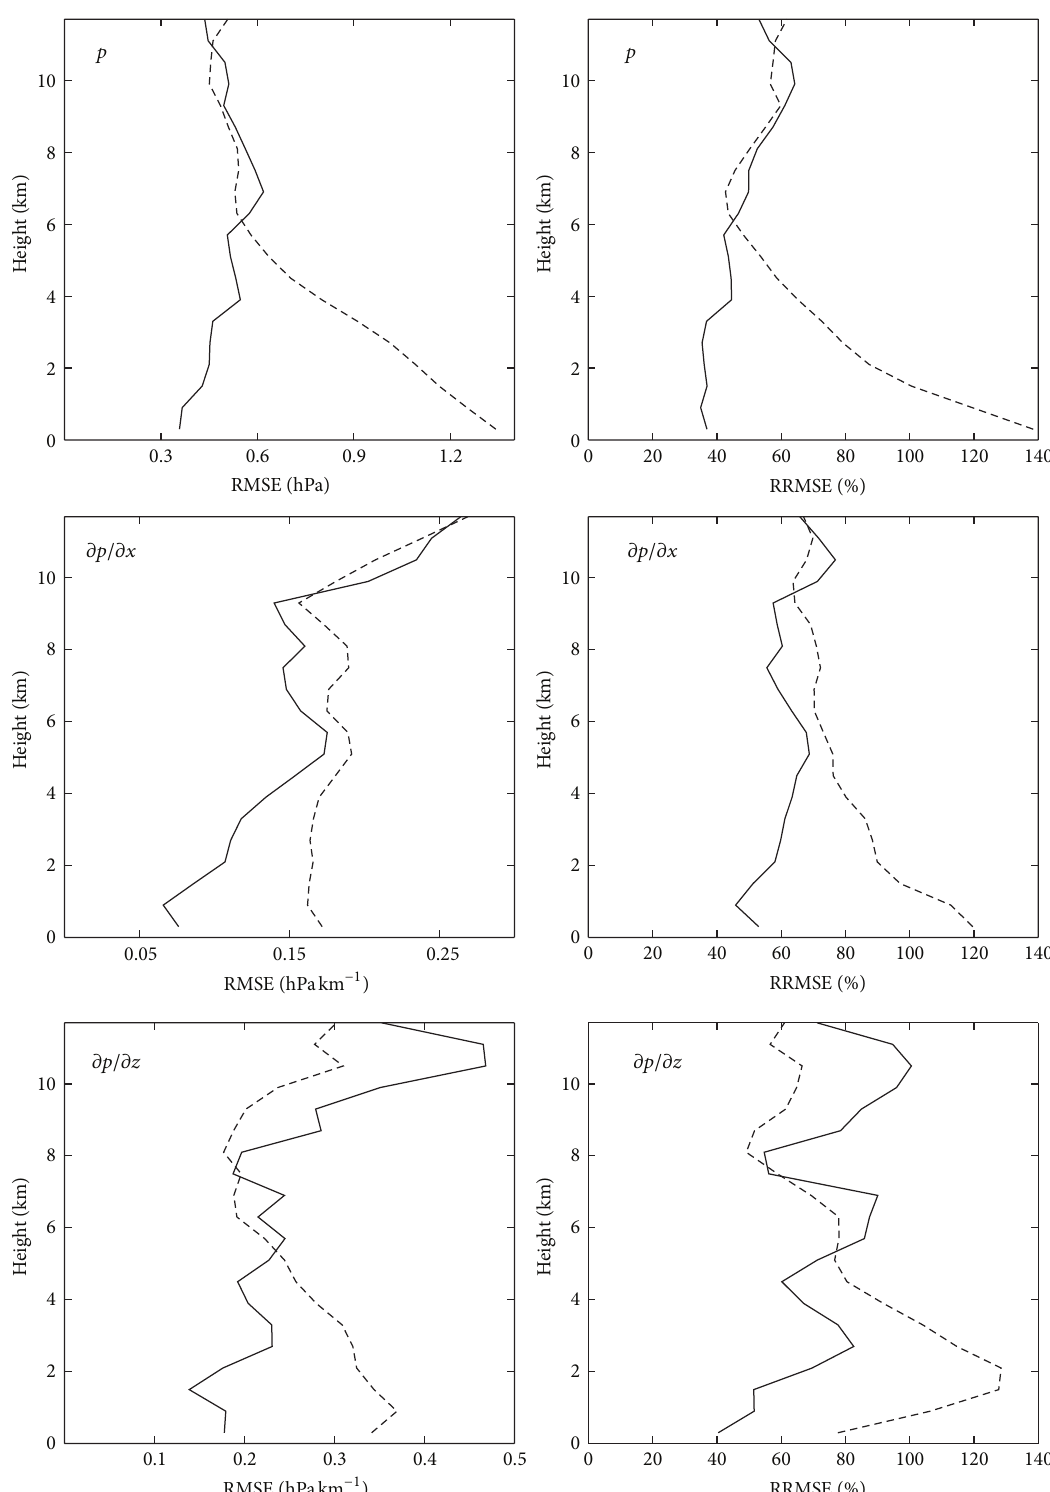
Figure 9: As in Figure 3 but for 𝑝 retrieved from mean EnKF posterior (solid) and mean EnKF posterior 𝑝 final